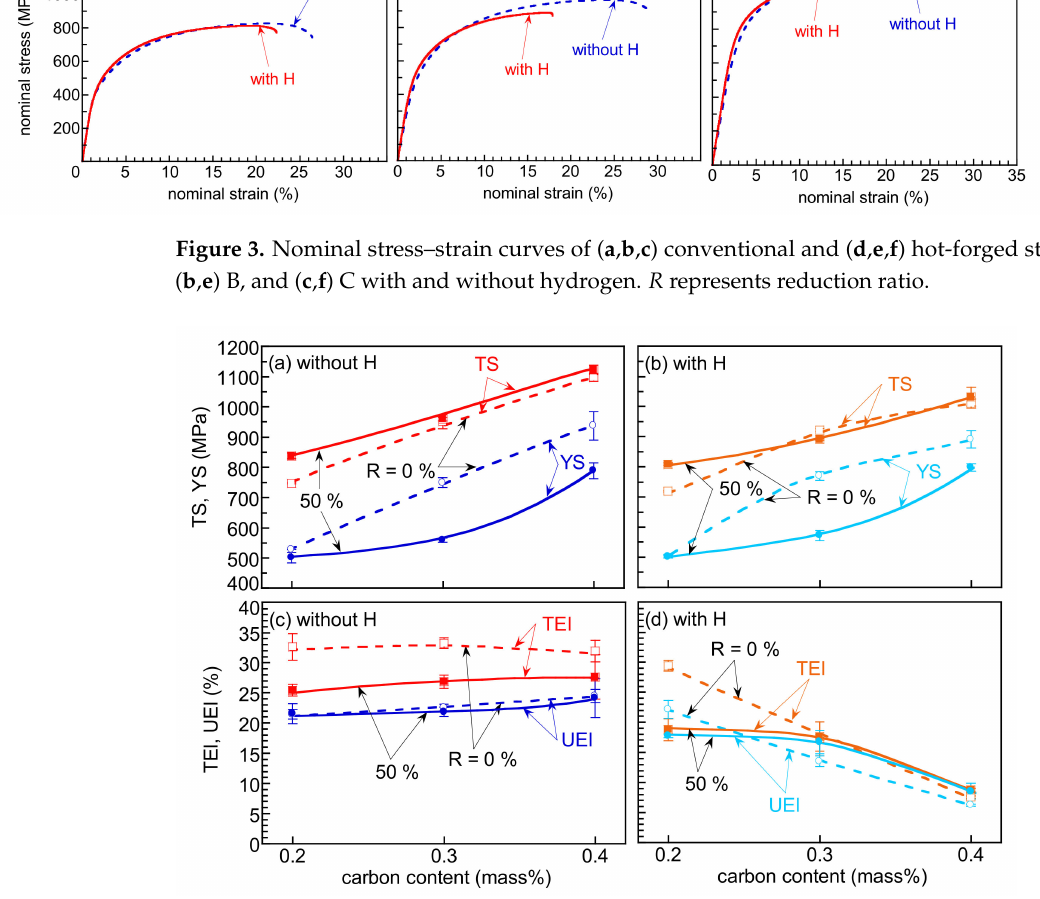
Figure 4. Variations in ( a , b ) tensile strength ( TS ), yield strength ( YS ), ( c , d ) total elongation ( TEl ), and uniform elongation ( UEl ) as a function of carbon content in conventional and hot-forged steels A, B, and C ( a , c ) without and ( b , d ) with hydrogen. R represents reduction